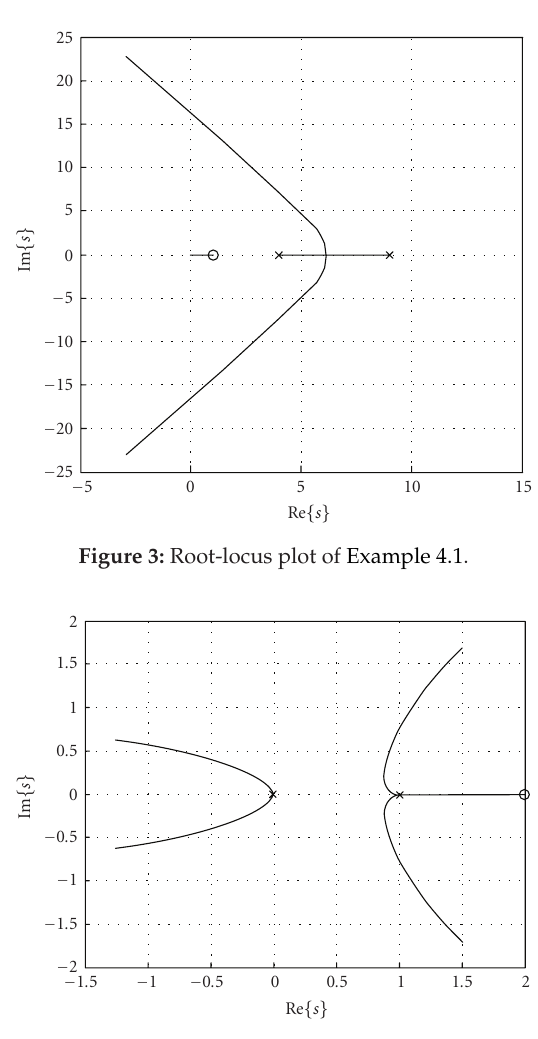
Figure 4: Root-locus plot of Example